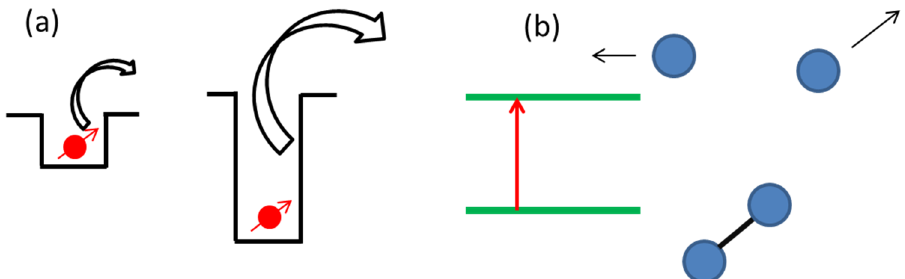
Figure 4. ( a ) Electron trapped in two different sites having different potential wells, which imply different de-trapping behaviors; ( b ) Dissociation of a molecule following the transition from the ground state to an excited non-bonding state.